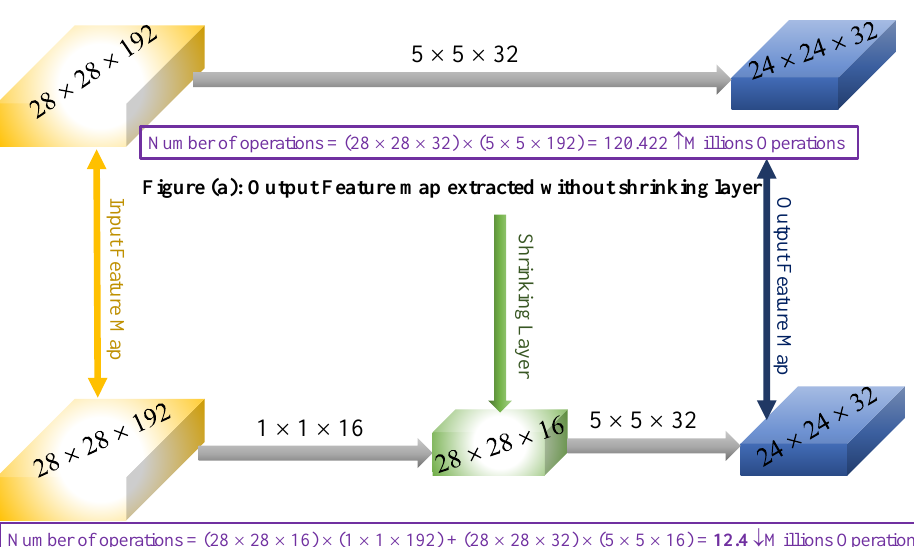
Figure (b): Output Feature map extracted with shrinking layer Figure 5. Demonstration of the number of operations with and without the shrinking